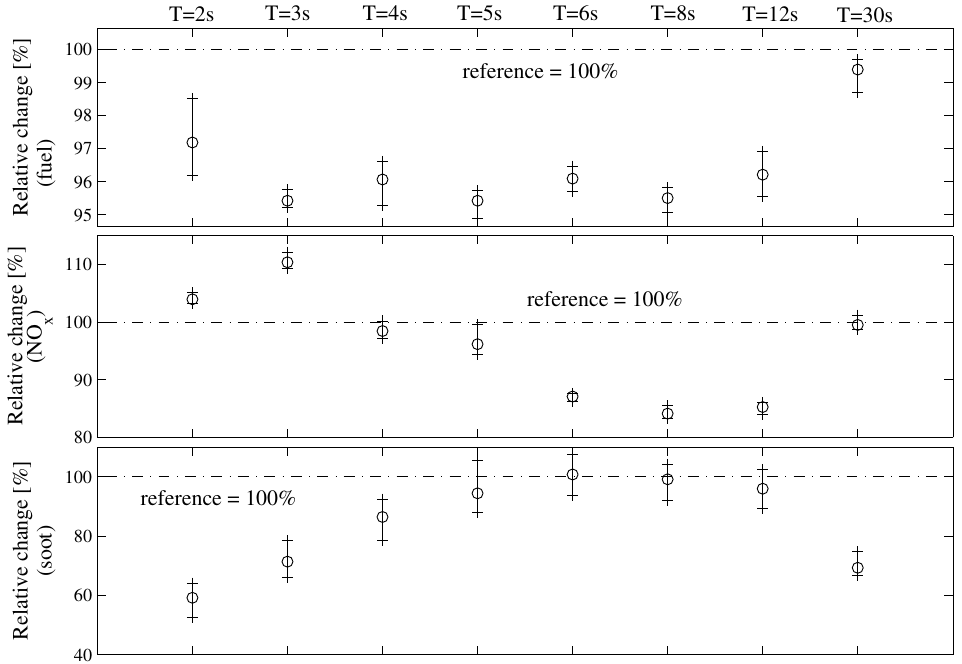
Relative change of fuel consumption, NO optimization. Average value and error bars calculated by repeating the measurement five time for each